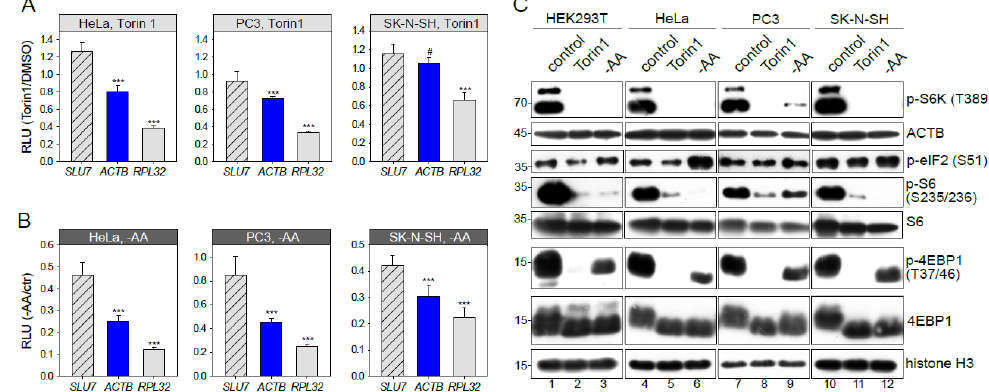
Figure 3. mTOR-sensitivity of β -actin mRNA translation is cell type-dependent. HeLa, PC3 or SK-N-SH cells were transfected with pNL2.2 . After 2h of 500 nM Torin1 treatment ( A ) or amino acid and serum starvation, -AA ( B ) the cells were lysed, and luciferase activity was measured. Student’s t -test was used to estimate the statistical significance versus SLU7 . ( C ) HEK293T, HeLa, PC3 or SK-N-SH cells were treated for 2h with DMSO (control), 500 nM Torin1, or subjected to amino acid and serum starvation (-AA). Cells were lysed and analyzed by Western blotting using the indicated antibodies. *** p < 0.001; # — nonsignificant.